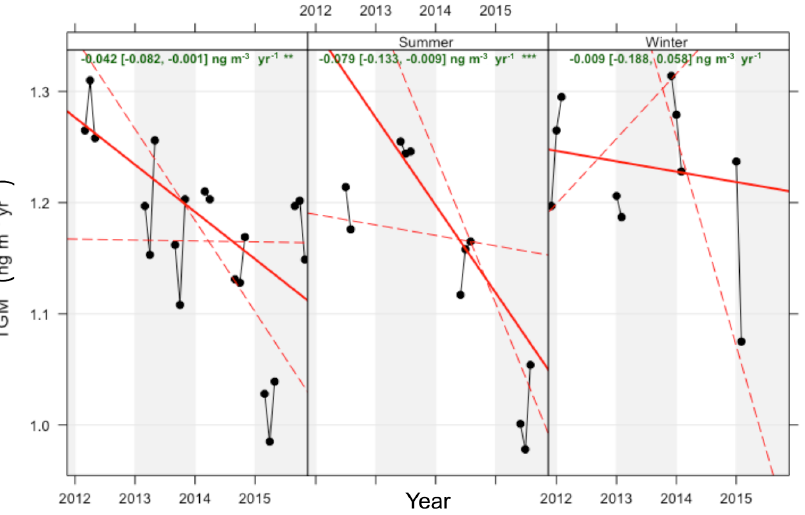
Figure 4. TGM trends for the full year and then separated by season at the Cape Verde Observatory. The green text shows the slope estimate, with 99% confidence intervals in